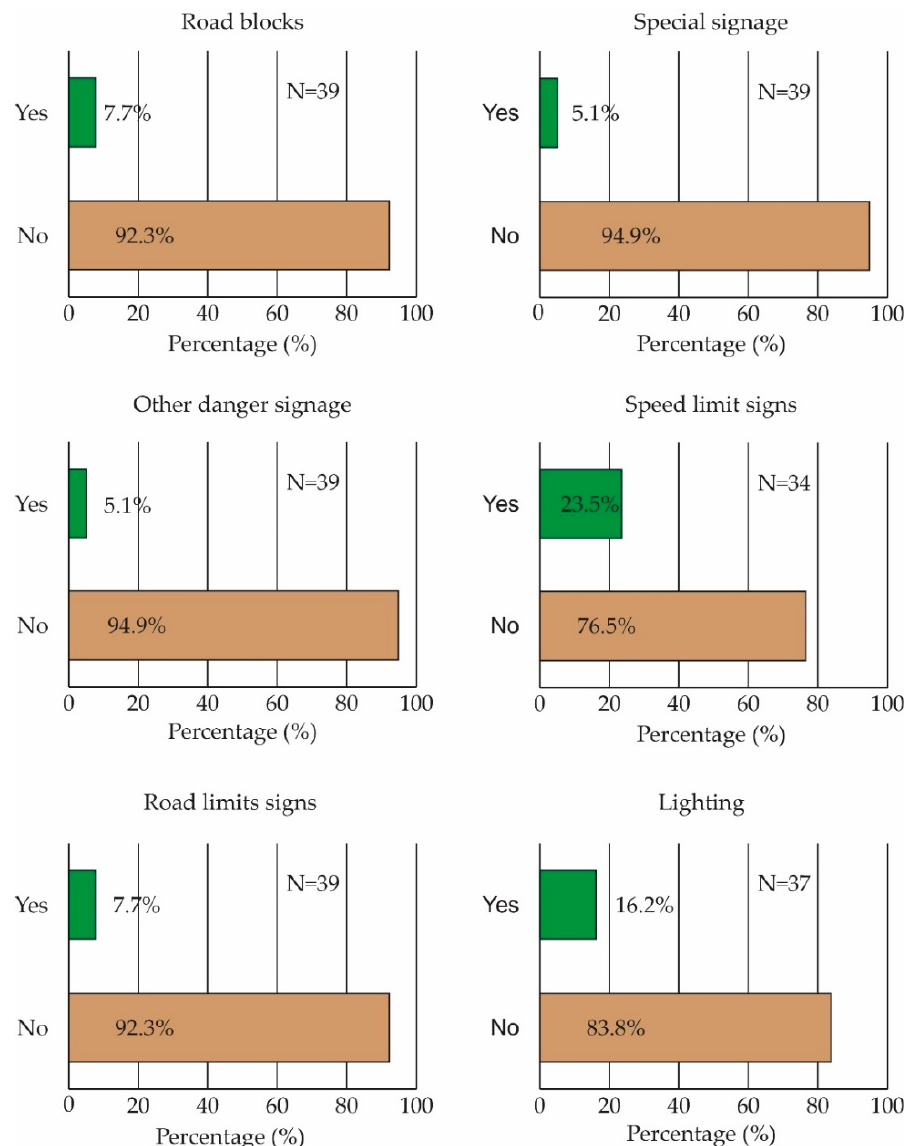
Figure 5. Distribution of cases with respect to signage and lighting.